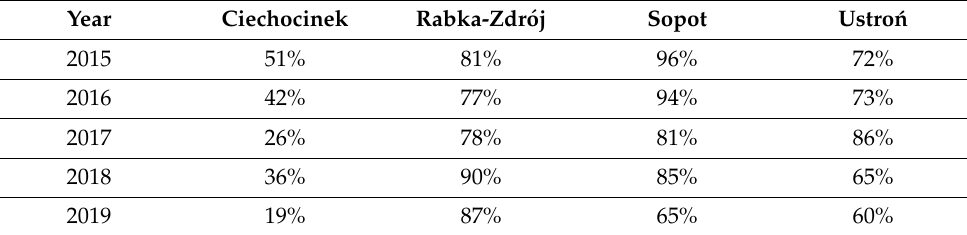
Table 10. Contribution of air quality stations with above-normal cancer risk lower than four health resorts in